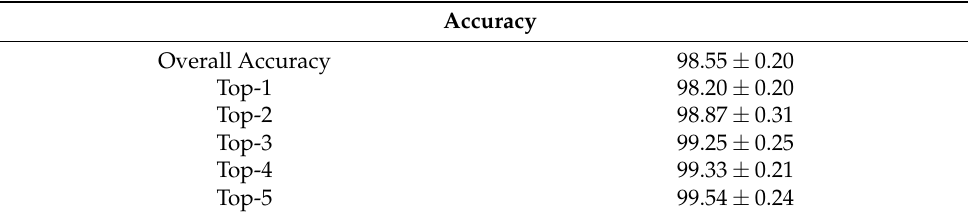
Table 3. The accuracy of the proposed system on the first session.